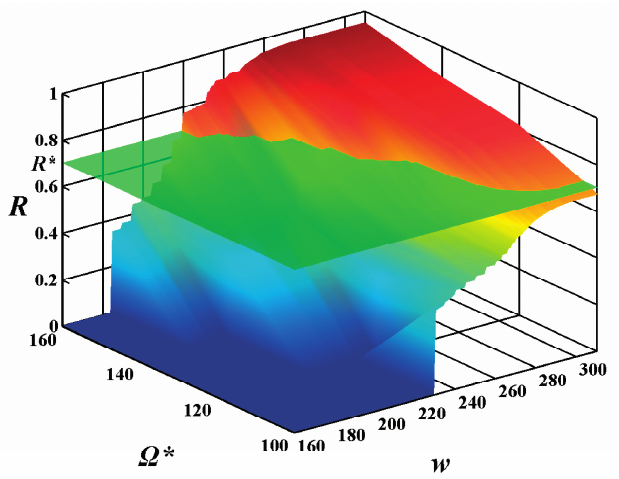
Figure 12. The selection for the most suitable Ω * and w * with alterations in the execution time w from 160 to 310 and in the given cost constraint Ω * from 100 to 160 under the given expected execution time w * = 250.